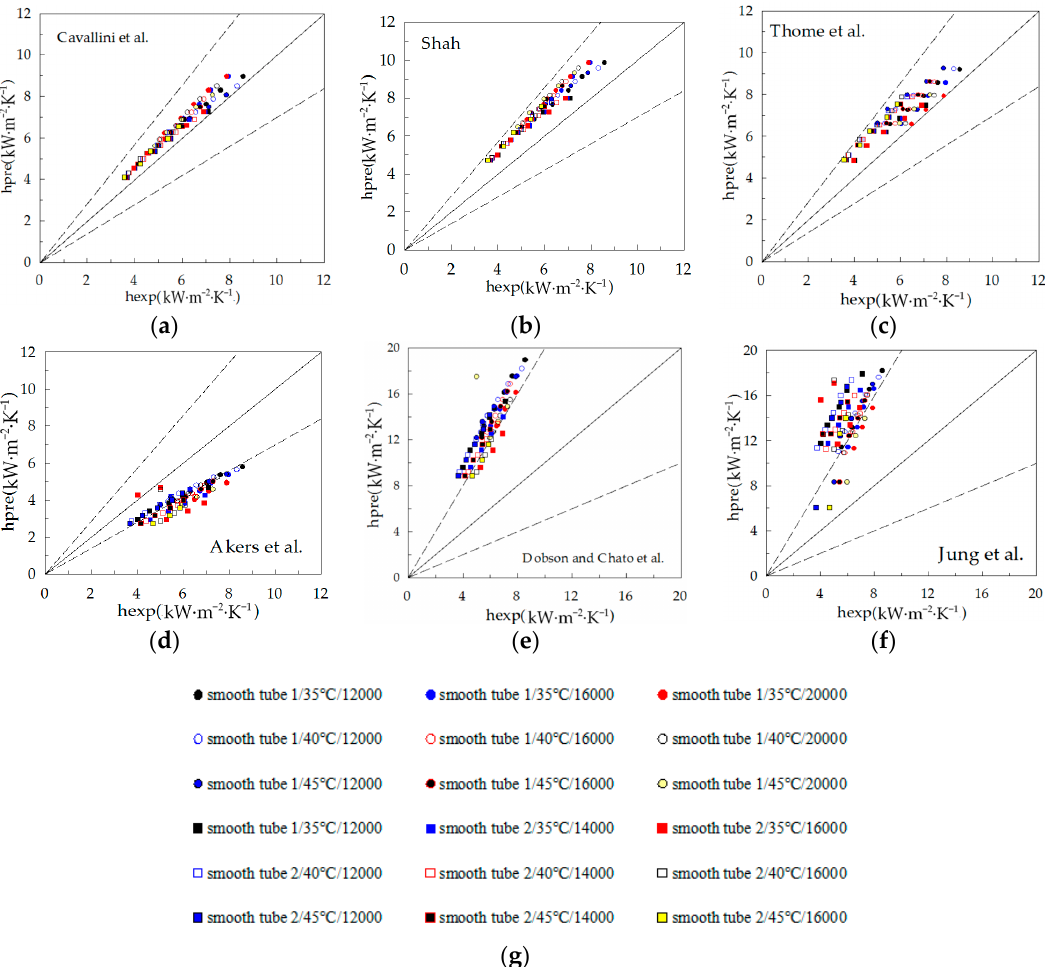
Figure 11. Comparison of prediction methods with experimental data for smooth tubes ( a ) Cavallini et al.; ( b ) Shah; ( c ) Thome et al.; ( d ) Akers et al.; ( e ) Dobson and Chato et al.; ( f ) Jung et al.; ( g ) instructions of point. Table 5. Deviation of various correlations against the experimental heat transfer